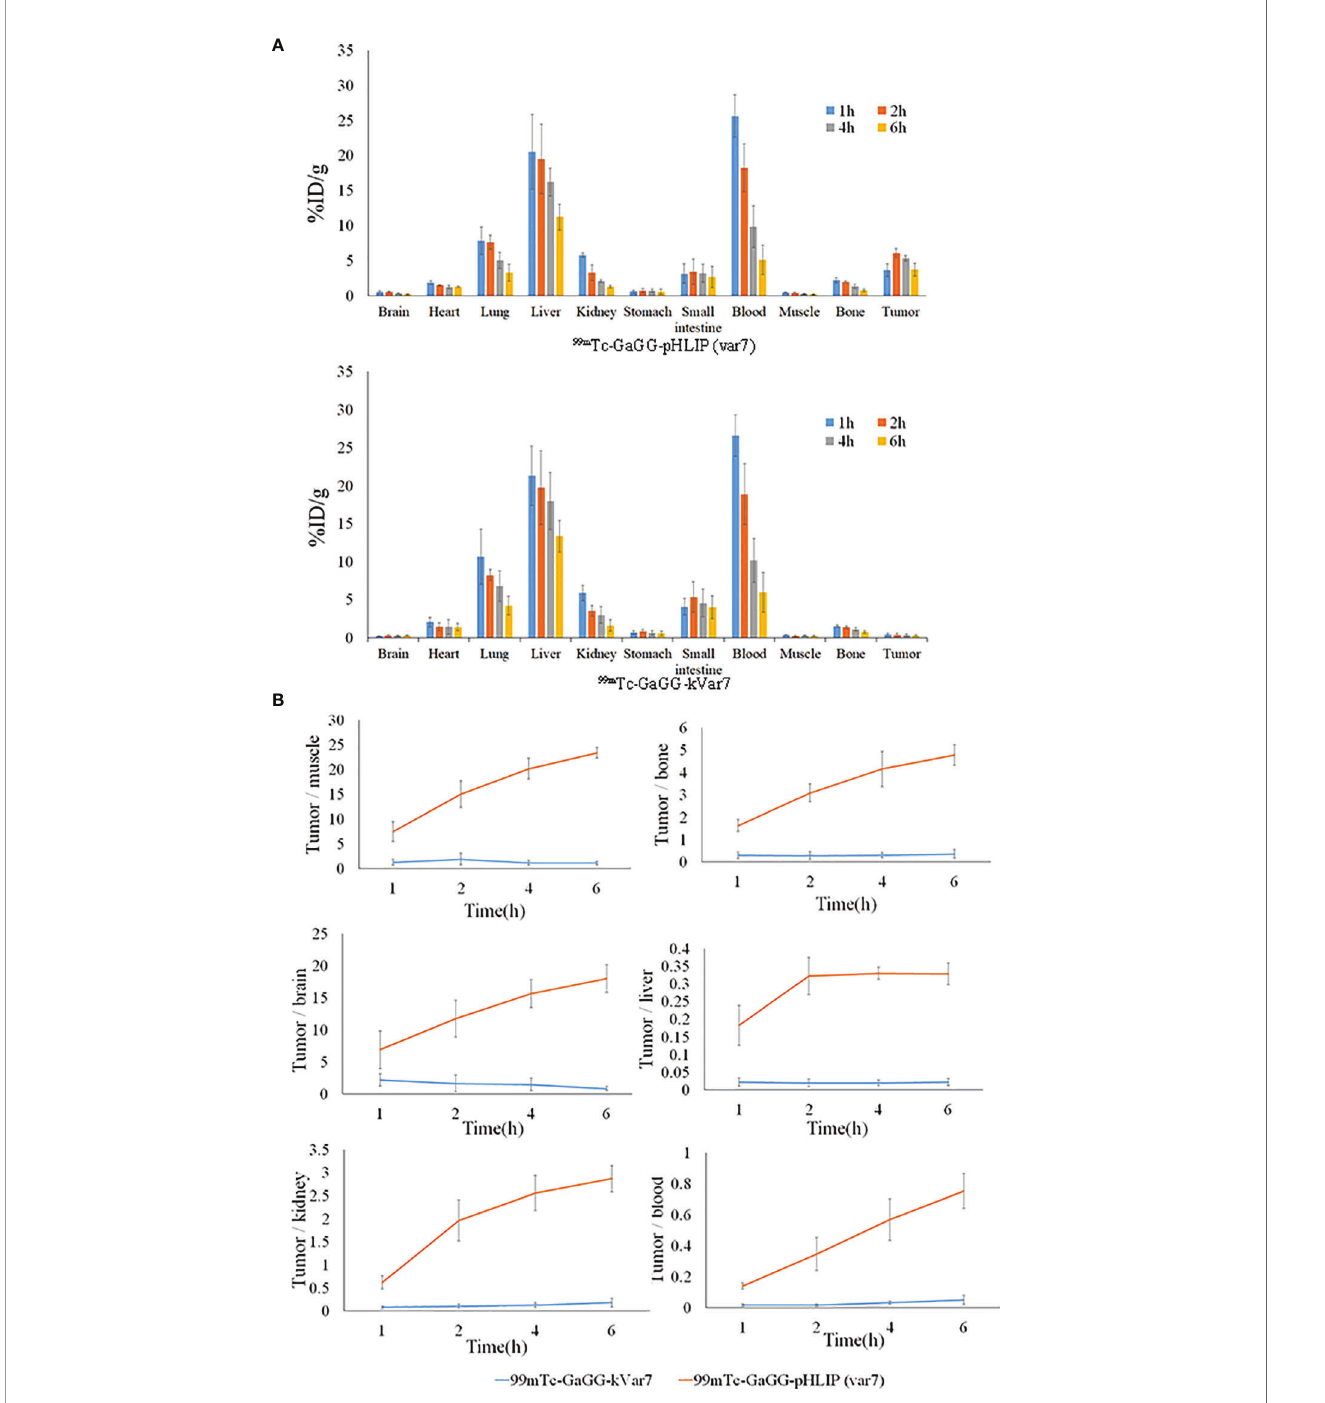
FIGURE 4 | The biodistribution (A) and T/NT ratio (B) of 99m Tc-pHLIP(Var7) and 99m Tc-kVar7 in mice with MDA-MB-231 tumors